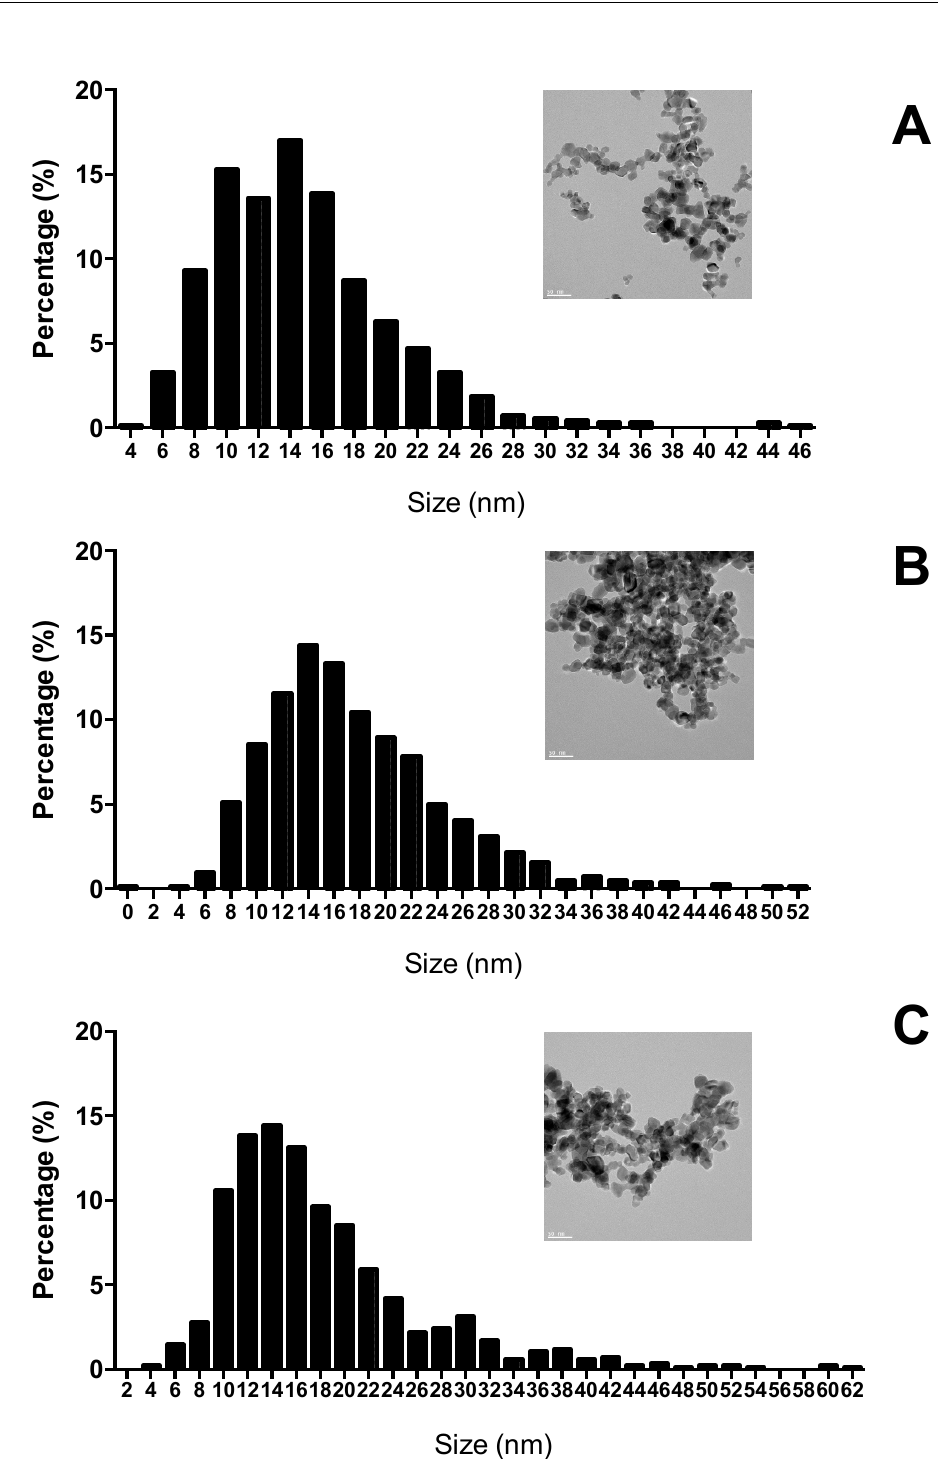
Figure 1. Scanning transmission electron microscope (STEM) images of titanium dioxide nanoparti- cles (TiO 2 NPs) suspensions (scale 50 nm) and their size distribution histogram. ( A ) stock suspension in distilled water; ( B ) exposure suspension in saline solution (NaCl 9 g L –1 ) and DMSO; ( C ) mixture of TiO 2 NPs + oxybenzone (BP-3) exposure suspension in NaCl (9 g L –1 ) and DMSO.